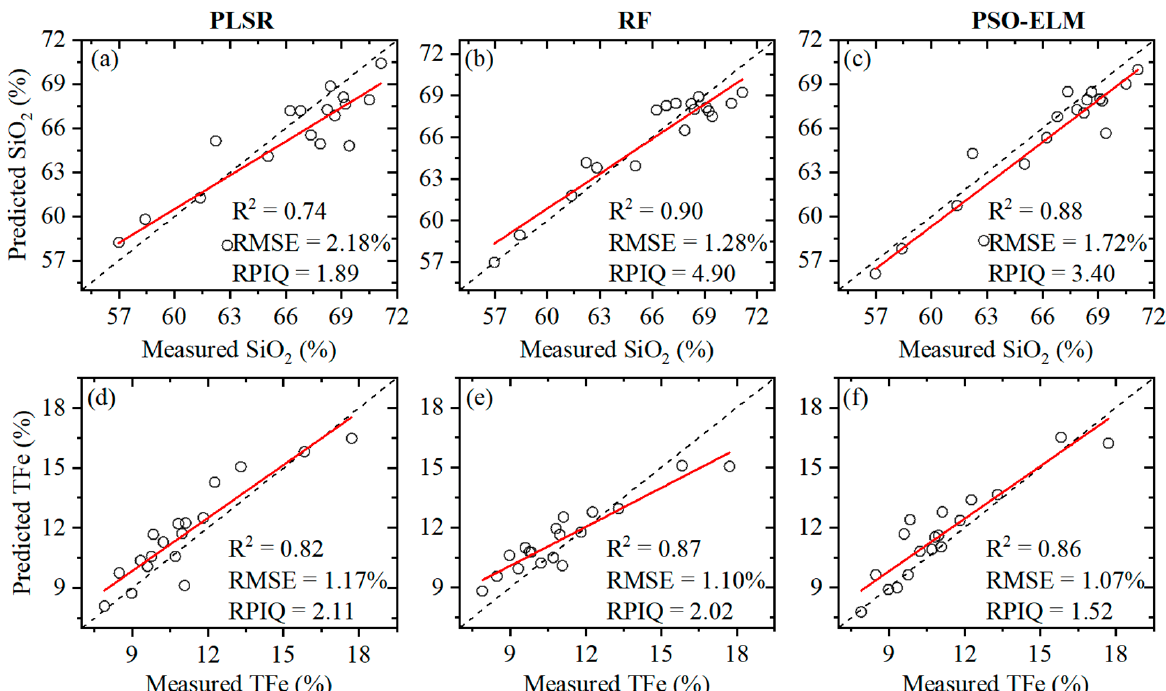
Figure 11. Validation between the measured and predicted value of SiO 2 ( a – c ) in the 1365–1391 nm, 1410–1623 nm, 8–9.4 μ m, and 10.7–12 μ m range, TFe ( d – f ) in the 1163–2499 nm, 8–9.4 μ m, and 10.7–12 μ m rangefrom data augmentation using the PLSR, RF, and PSO–ELM models. The dashed line shows the 1:1 relationship and the red line shows the model trend.